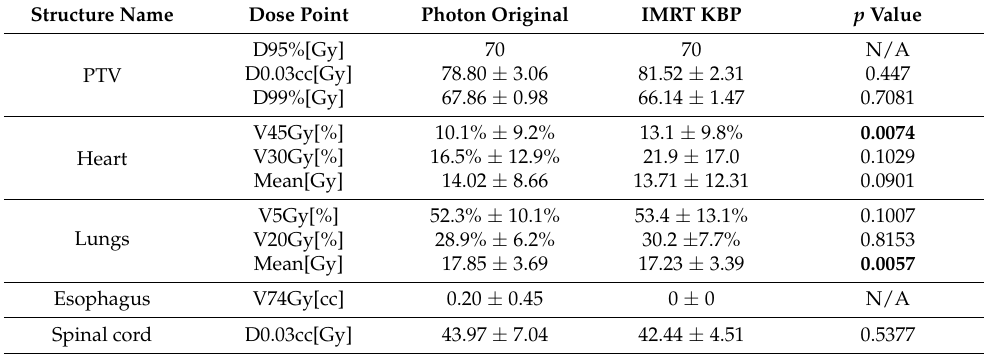
Table 4. Dose comparison and t -test results of forty submitted IMRT versus KBP IMRT plans. (All IMRT plans were normalized so that 70Gy will cover 95% of the PTV